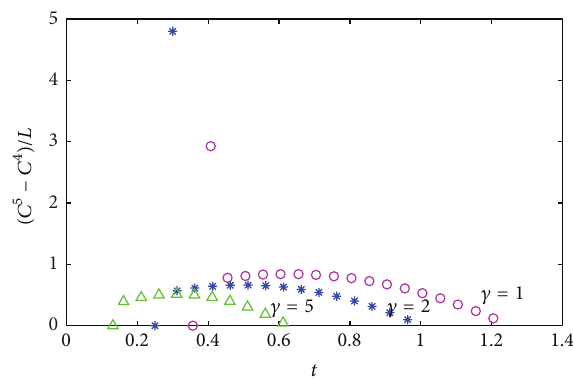
Figure 4: The severity in which the paradox